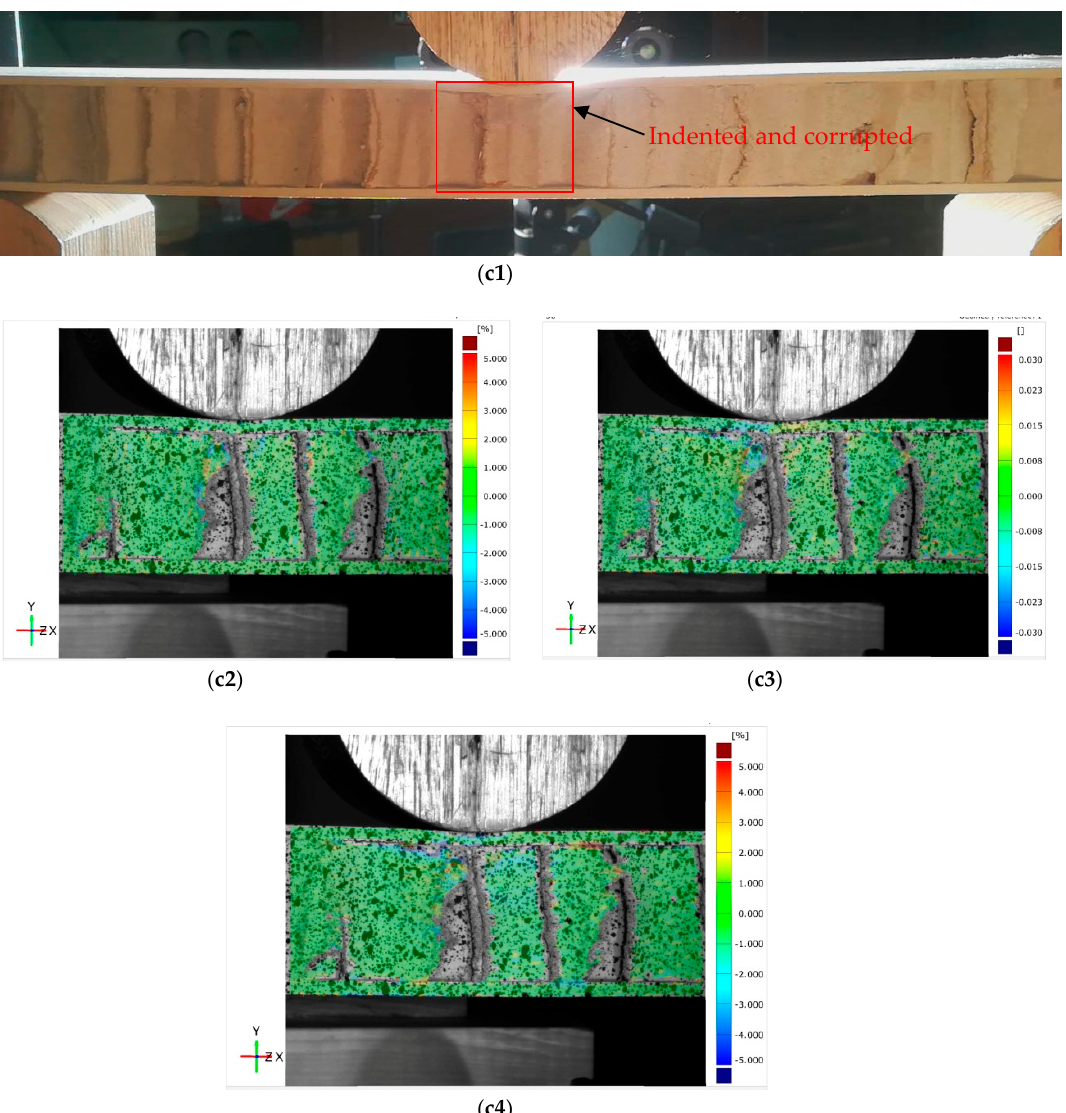
Figure 6. Photographs and strain distribution of the indentation process of the wooden sandwich beam with Taiji honeycomb core: a1 for photograph, a2 for (cid:101) x , a3 for γ xy and a4 for ε y under unloaded condition; b1 for photograph, b2 for (cid:101) x , b3 for γ xy and b4 for ε y under initiation of indentation; c1 for photograph, c2 for (cid:101) x , c3 for γ xy and c4 for ε y after